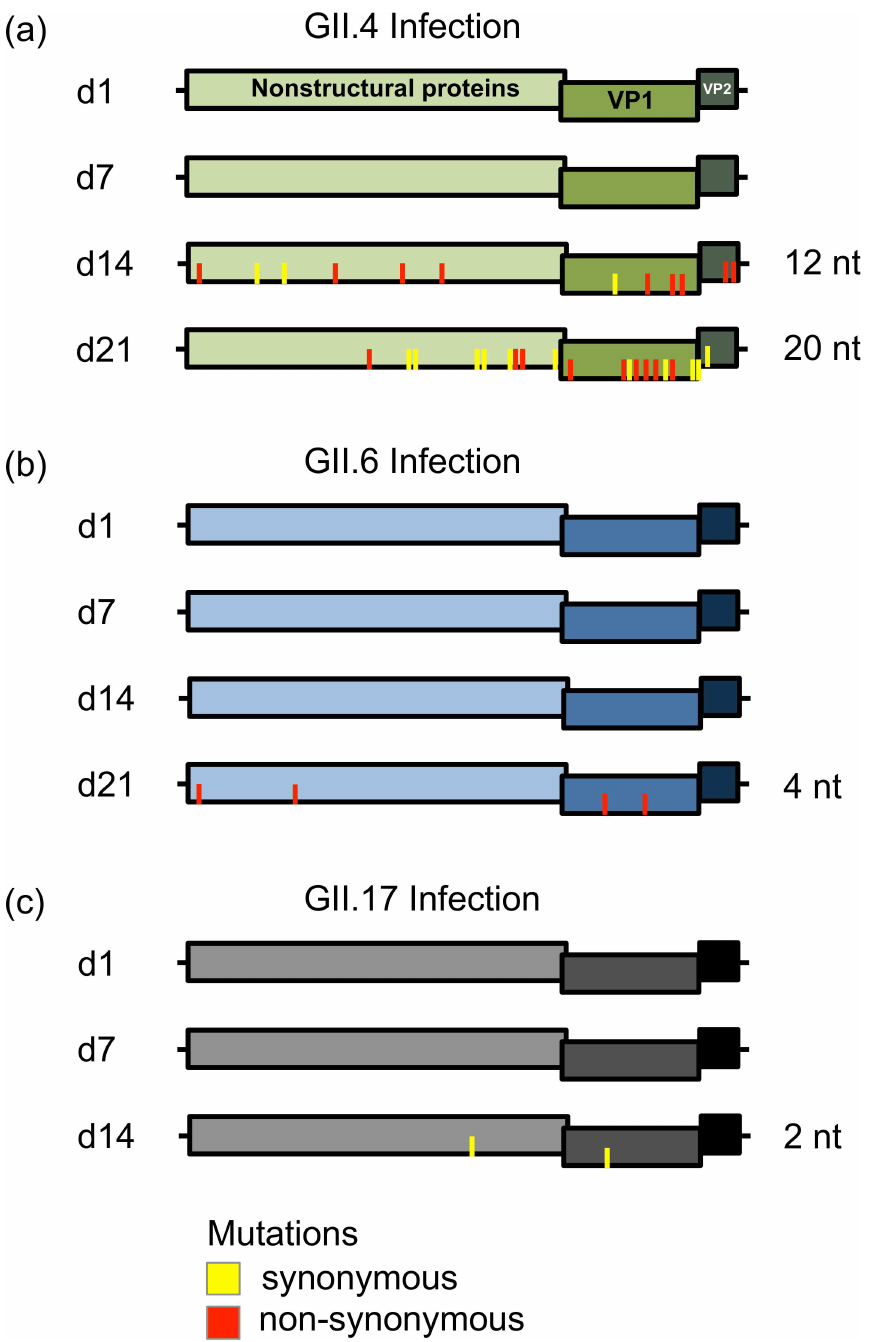
Fig 3. Intra-host diversity of noroviruses in an immunocompetent individual with three sequential norovirus infections. Summary of NGS data from consecutivesamplescollectedfrom an individualwho shed (a) GII.4 (Sydney variant), (b) GII.6 (B variant), or (c) GII.17 (D variant) norovirusfor 2–3 weeks (Days 1, 7, 14, and 21). All consensus sequenceswere identicalto the reference (Day 1); however,mutations ranging from 5 to 50% of the total reads (indicatedwith yellow bars, synonymous, and red bars, non-synonymous) arose at later time points for each virus. GII.4 viruses are indicatedin green, GII.6 in blue, and GII.17 in grey.